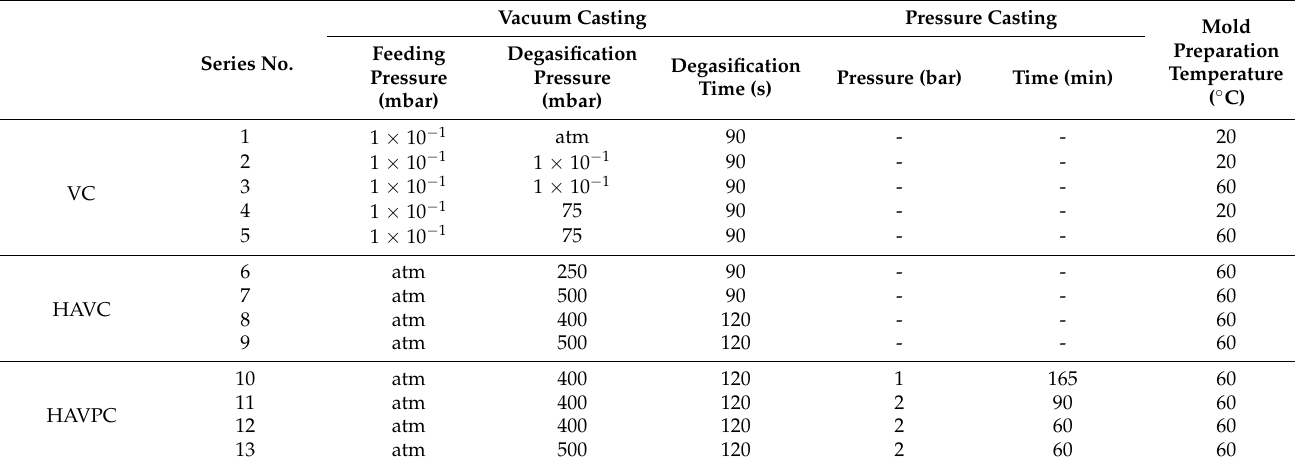
Table 3. Parameters of the series of specimens manufactured by Vacuum Casting (VC), Hybrid atmospheric-vacuum casting (HAVC), and Hybrid atmospheric-vacuum-pressured casting (HAVPC) processes.